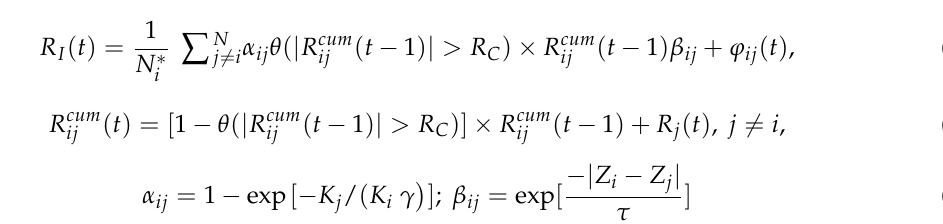
Figure 6 A price-quake. One of the main advantages of the nonlinearity in the integrate-and-fire oscillator model is that it enables a clear-cut identification of cause and effect. The figure shows one example of a price-quake, following an initial minus 7% price movement on the Japanese stock market on 23 May 2013. The figure is taken from (Liu et al. 2017).